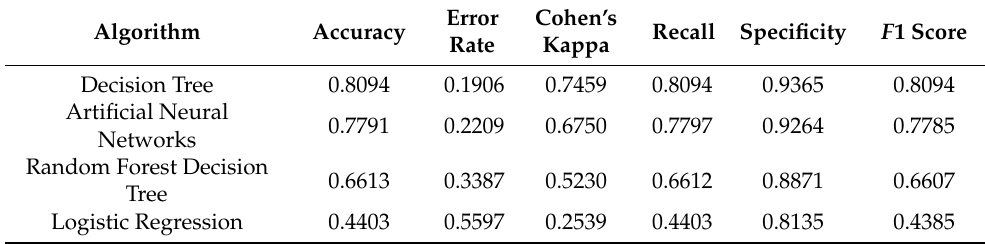
Figure 2. Analysis framework.